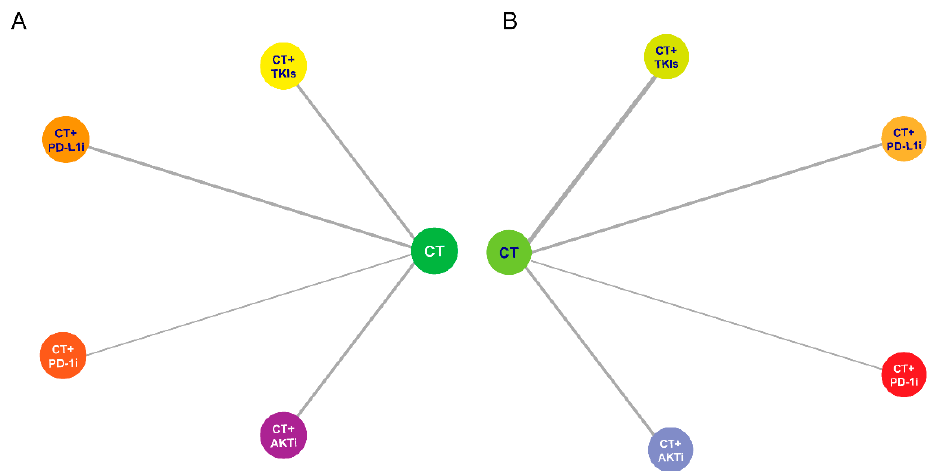
Figure 2. Network plot of the therapeutic options included in comparative analysis. ( A ) Therapeuutic options included for pooled PFS. ( B ) Therapeuutic options included for pooled OS. Abbreviation: AKTi, Protein kinase B inhibitor; CT, Chemotherapy; PD-1i, Programmed cell death protein 1 inhibitor; PD-L1i, Programmed cell death ligand 1 inhibitor; TKIs, Tyrosine kinase inhibitors.